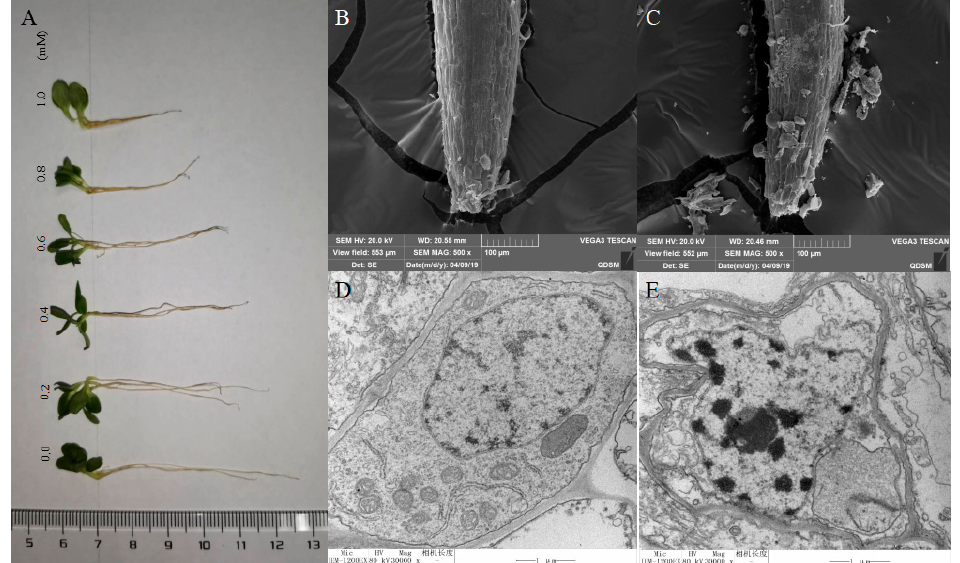
Figure 3. Pictures of the effect on growth length of lettuce radicles treated with isoliquiritigenin: ( A ) scanning electron microscope images of lettuce radicle surface under control ( B ) and treatment ( C ) with isoliquiritigenin (1 mM), and representative transmission electron microscope images of the ultrastructure of lettuce radicle cells under control ( D ) and treatment ( E ) with isoliquiritigenin (1 mM).